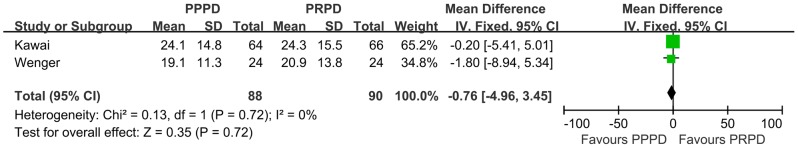
Forest plot of hospital stay.The 95% confidence interval (CI) for the hazard ratio for each study is represented by a horizontal line and the point estimate is represented by a square. The size of the square corresponds to the weight of the study in the meta-analysis. The 95% CI for pooled estimates is represented by a diamond. Data for a fix-effects model is shown as there was no statistical heterogeneity (I2 = 0%). df  =  degrees of freedom; I2 =  percentage of the total variation across studies due to heterogeneity; IV =  Inverse Variance; Z =  test of overall treatment effect.